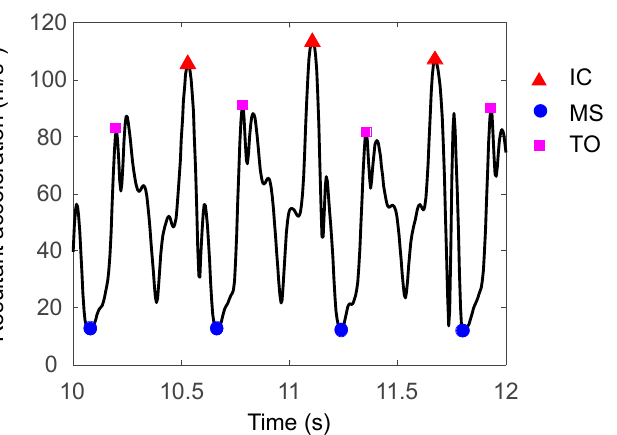
Figure 1. Location of inertial measurement unit and its coordinate system.